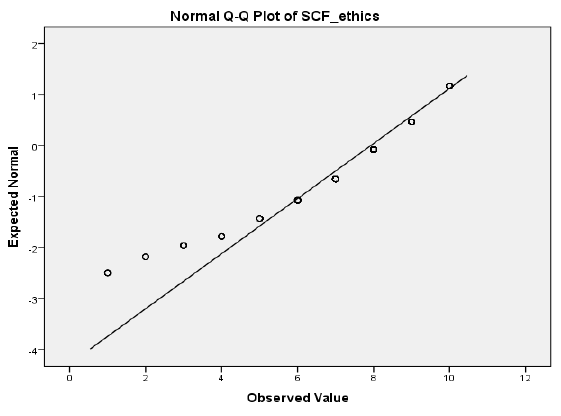
Fig. 2. EB Q-Q plot. Source: authors’